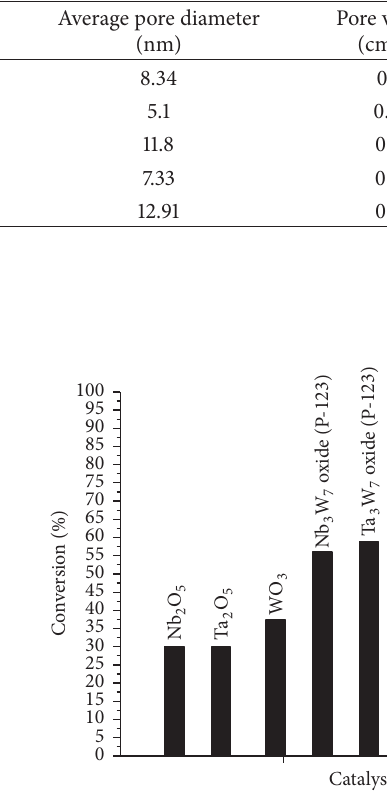
Figure 9: Effect of solid acid catalysts on the esterification reactions at 180 ∘ C.